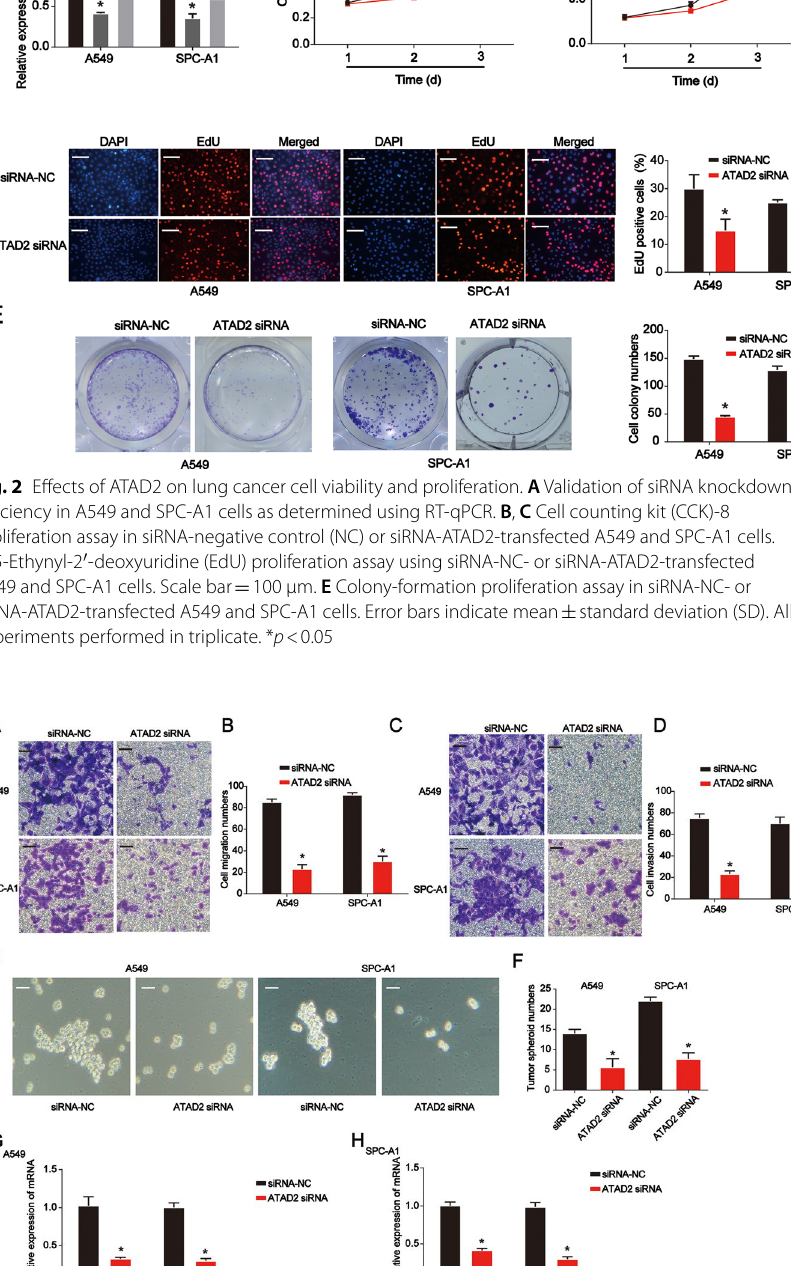
100 μm. G , H CD133 =